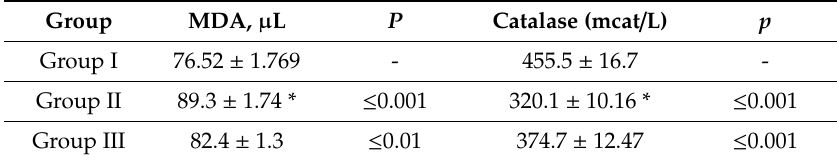
Table 5. Impact of preventive Acyzol administration on catalase activity and malondialdehyde (MDA) concentration in experimental animals chronically intoxicated with lead acetate. Group MDA, µ